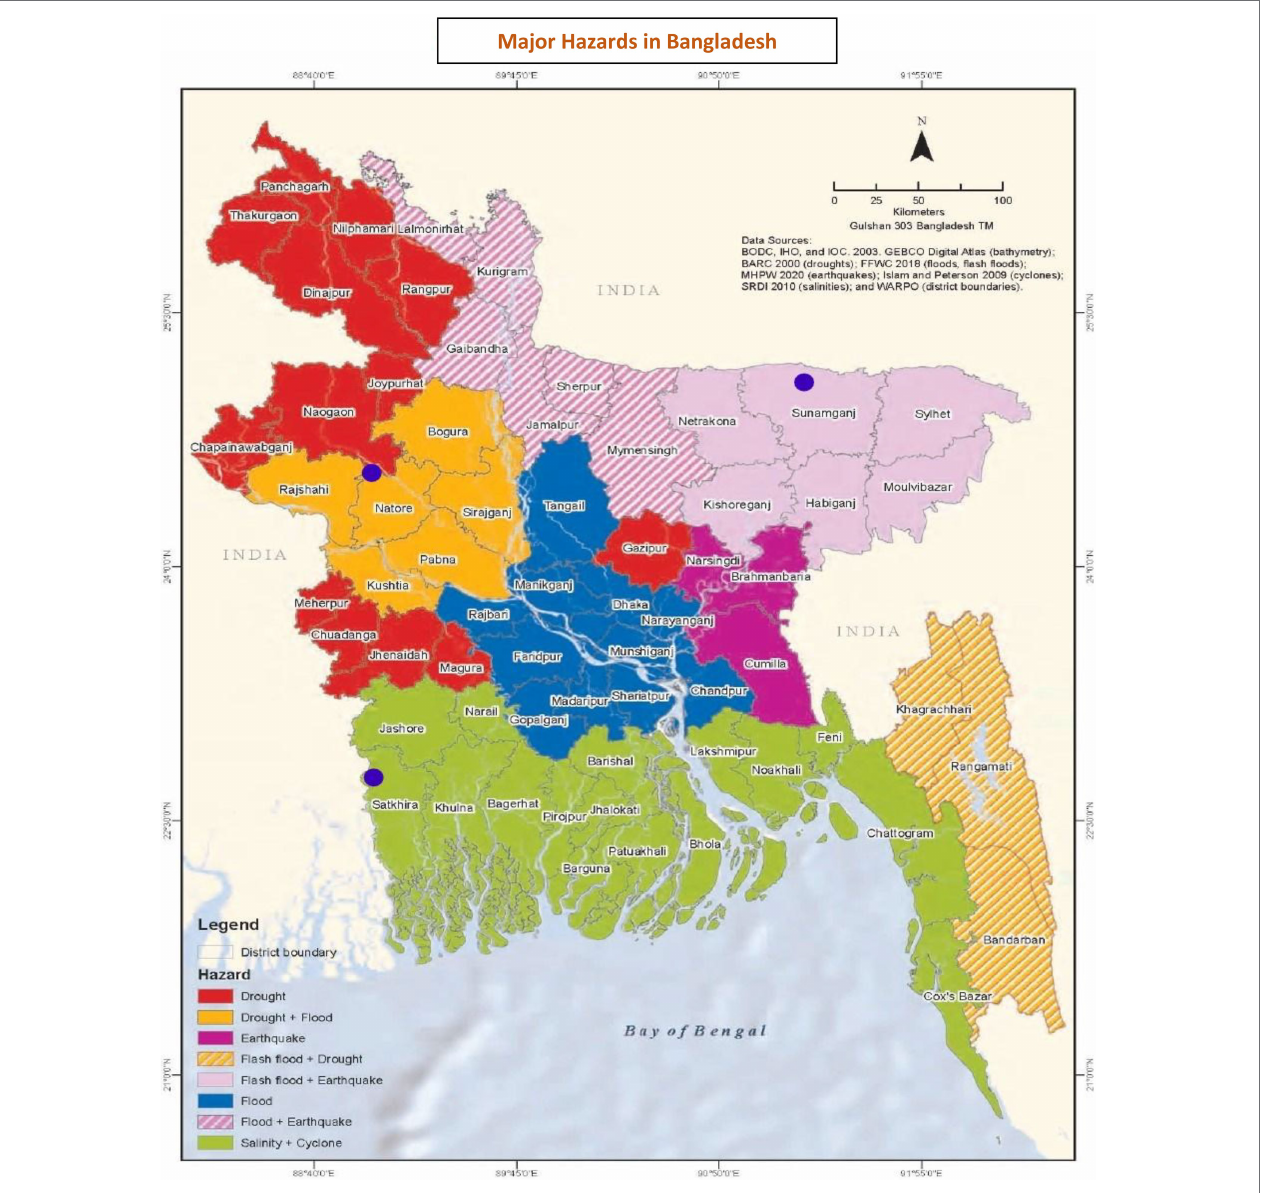
FIGURE 1 | Areas vulnerable to different types of extreme weather event (EWE) and study locations (Bangladesh). The purple dots indicate the locations of the three upazilas included in this study. Source: https://www.adb.org/sites/default/files/publication/760781/bangladesh-climate-disaster-risk-atlas-volume2-cover-